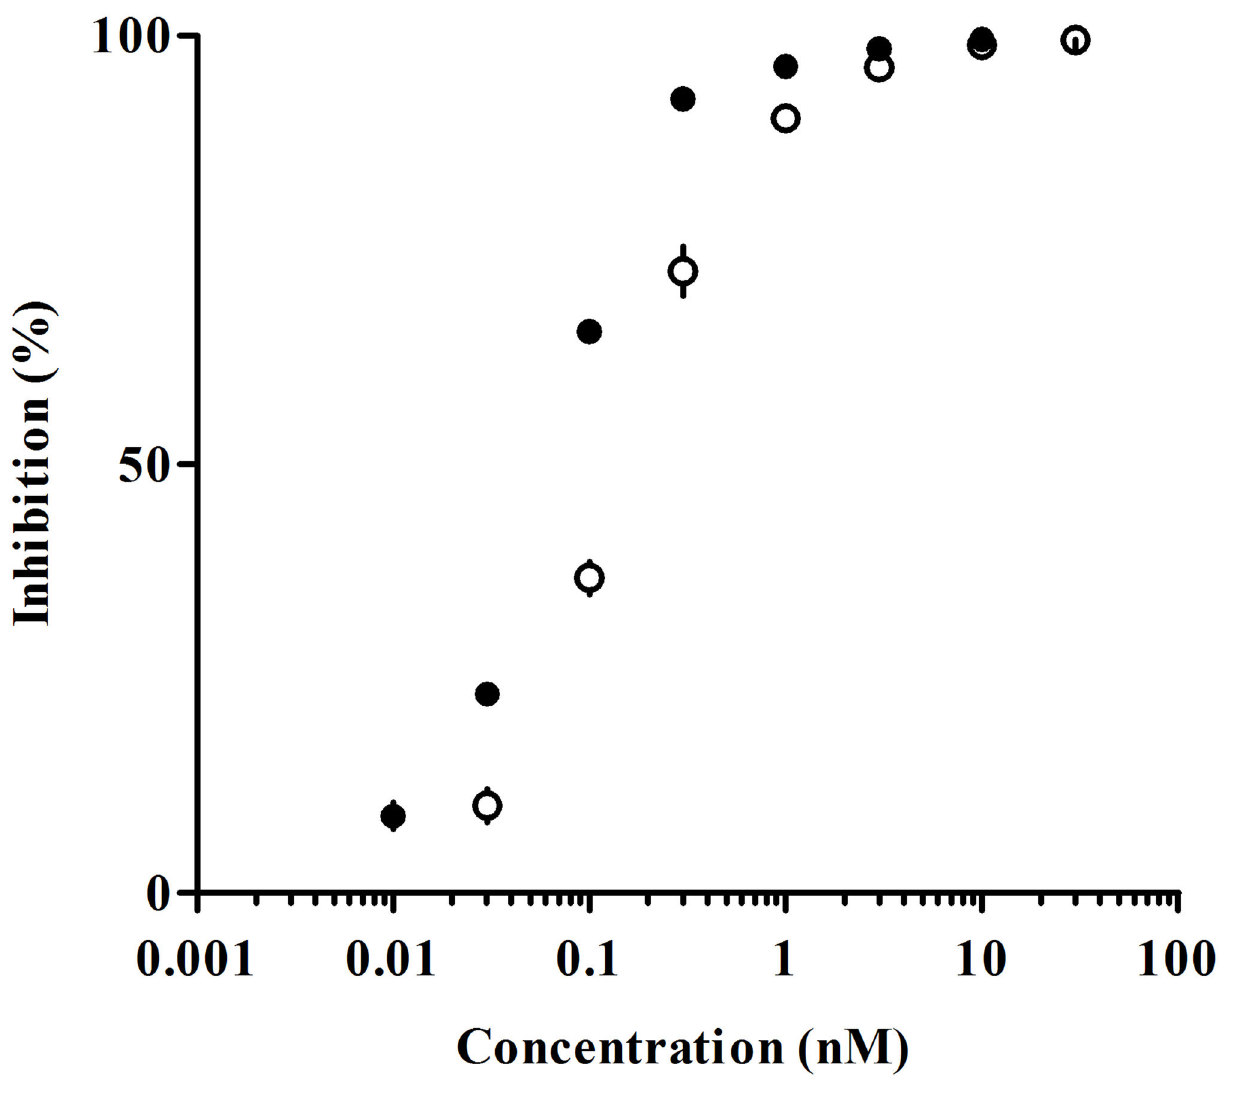
Figure 3. In vitro inhibition profiles of E2110 and WAY-100635 on 5-HT rat hippocampal membrane homogenates was measured at various concentrations of E2110 (●) and WAY-100635 (○).